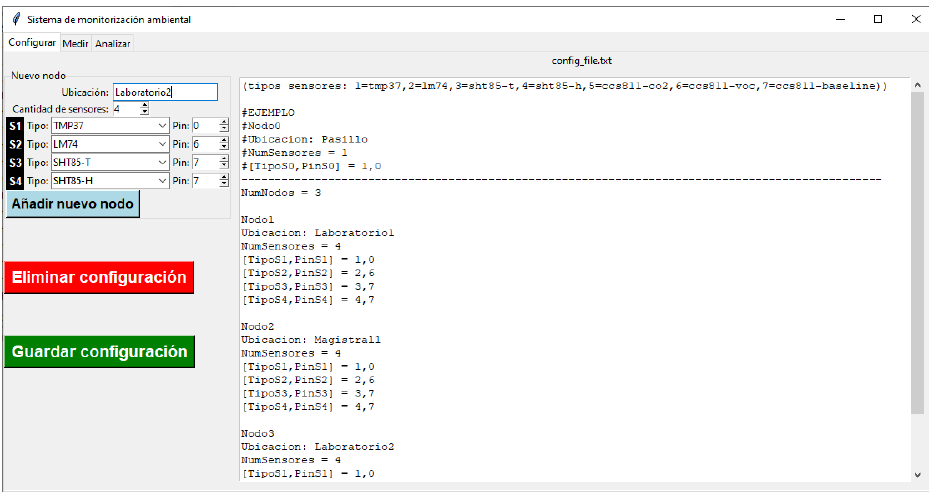
Figure 6. HMI application: Configuration of the IEQ monitoring system.